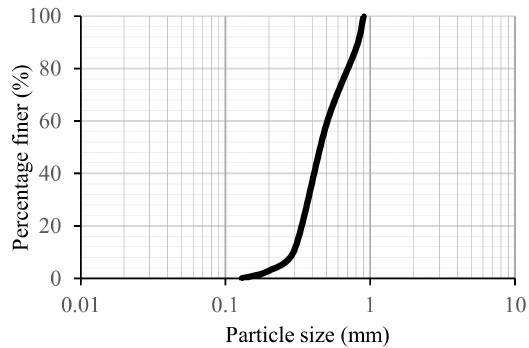
Figure 1. Particle size distribution.